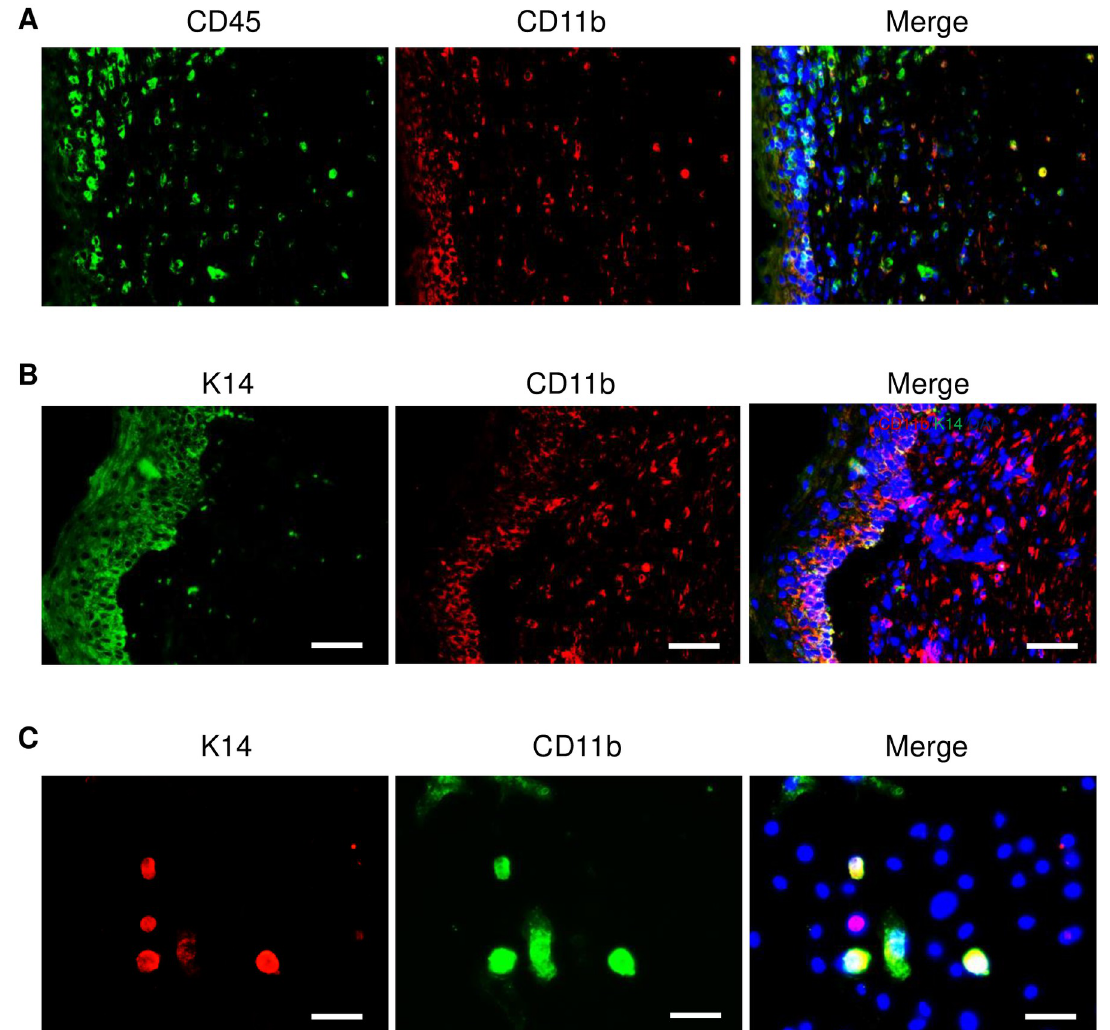
Fig 3. Myeloid cells are the cellular origin of hematopoietic cell-converting keratinocytes. ( A ) Double immunofluorescent staining with antibodies of CD45 and myeloid cell marker CD11b in wounded skin of mice. ( B ) Double immunofluorescent staining with antibodies of CD11b and K14 in wounded skin of mice. ( C ) Double immunofluorescent staining with antibodies of CD11b and K14 in cultured skin cells. Skin cells were isolated by collagenase digestion from wounded edge skin of Balb/C mice after injury for 14 days and cultured for 48 hours in vitro before fixation and staining. DAPI (blue) was used as a nuclear counterstain. Scale bars in all images was 50 μ m.